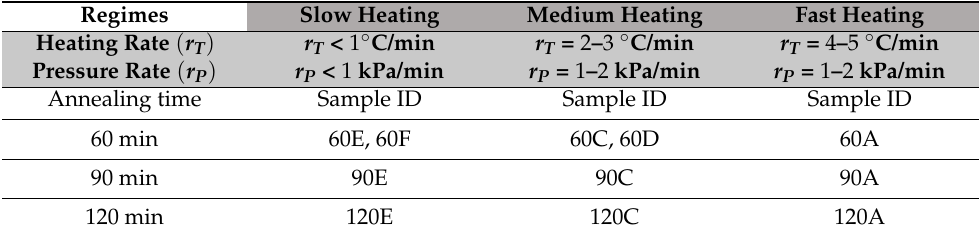
Table 1. List of the samples with relevant temperature and vapour pressure ramp annealed at three different regimes (slow, medium and fast heating) in the oven under THF solvent atmosphere for 60, 90 and 120